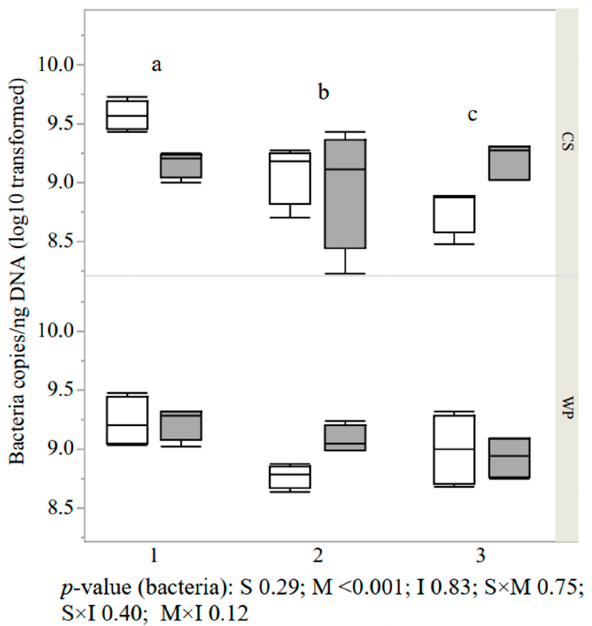
Figure 3. Effects of substrate, time after ensiling, and inoculation of Lactobacillus plantarum on total bacterial 16S rRNA gene copies in silage (n = 4). Substrates are shown in different panels. CS, sweet corn stover; WP, sweet corn whole plant. Sampling time points (months after ensiling) are scattered along the x axis. Inoculation with Lactobacillus plantarum is indicated with gray filling in the box plots. p -values for the following effects are provided in legends below the graph: M, Months after ensiling; S, substrate; I, inoculation; S × M, interaction between substrate and month; S × I; interaction between substrate and inoculation; M × I; interaction between month and inoculation. abc Unlike letters indicates differences ( p < 0.05) among time points after ensiling. Bacterial genera dominating fresh CS and WP forages before ensiling were Pseudo- monas , Klebsiella , Pantoea , Enterobacter , and Lactococcus (Figure 4). Lactobacillus accounted for only 0.4% of total bacterial amplicons in both CS and WP before ensiling. The Shannon bacterial diversity index at the genus level was higher in WP silage than in CS silage ( p < 0.001, Figure 5). Inoculation resulted in lower Shannon index regardless of the ensiling substrate or month ( p = 0.004; interaction S × I, p = 0.12; interaction M × I, p = 0.13). The Shannon diversity index of Lactobacillus OTUs was consistently lower in the inoculated silages ( p ≤ 0.003).